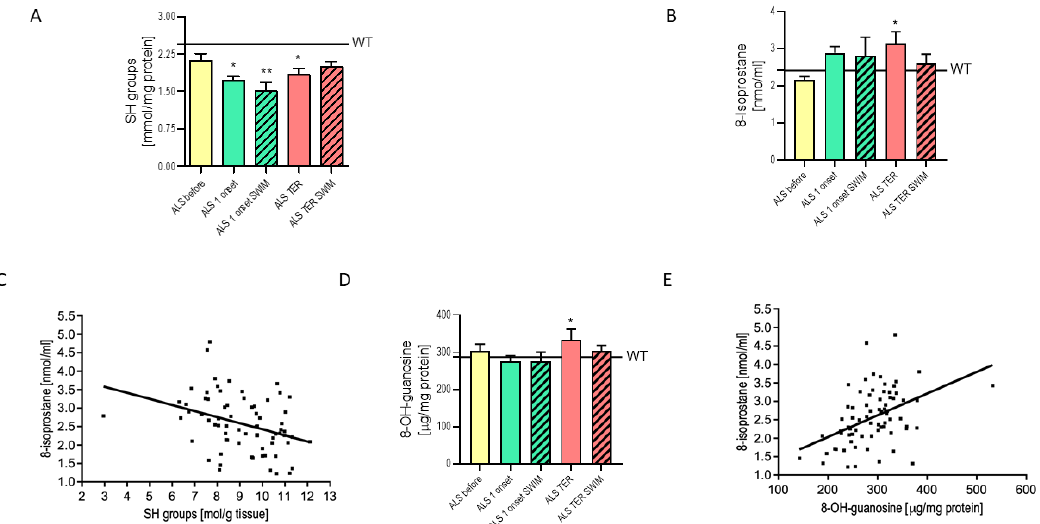
Figure 5. The concentration of the markers of free radical damage in spinal cord: ( A ) The SH groups concentration, WT = 2.43 ± 0.17 mmol/mg protein, * p < 0.05 versus the WT, ** p < 0.05 versus the ALS before and WT groups (WT n = 7, ALS before n = 8, ALS 1 onset n = 7, ALS 1 onset SWIM n = 6, ALS TER n = 9, ALS TER SWIM n = 10). ( B ) The 8-Isoprostanes concentration, WT = 2.39 ± 0.29 nmol/mL, * p < 0.05 versus the ALS before group (WT n = 7/8, ALS before n = 8/8, ALS 1 onset n = 7/8, ALS 1 onset SWIM n = 6/7, ALS TER n = 9/10, ALS TER SWIM n = 10/10). ( C ) The negative correlation of SH groups with 8-Isoprostanes, p < 0.05, r = −0.35. ( D ) 8-OH guanosine concentration, WT = 287.2 ± 21.1 µg/mg protein, * p < 0.05 versus the ALS 1 onset group (WT n = 7/8, ALS before n = 8/8, ALS 1 onset n = 7/8, ALS 1 onset SWIM n = 6/7, ALS TER n = 9/10, ALS TER SWIM n = 10/10). ( E ) The positive correlation of 8-OH guanosine with 8-Isoprostanes, p < 0.05, r = 0.447. For ( A , B , D ) LSD post hoc tests were used after one-way ANOVA.